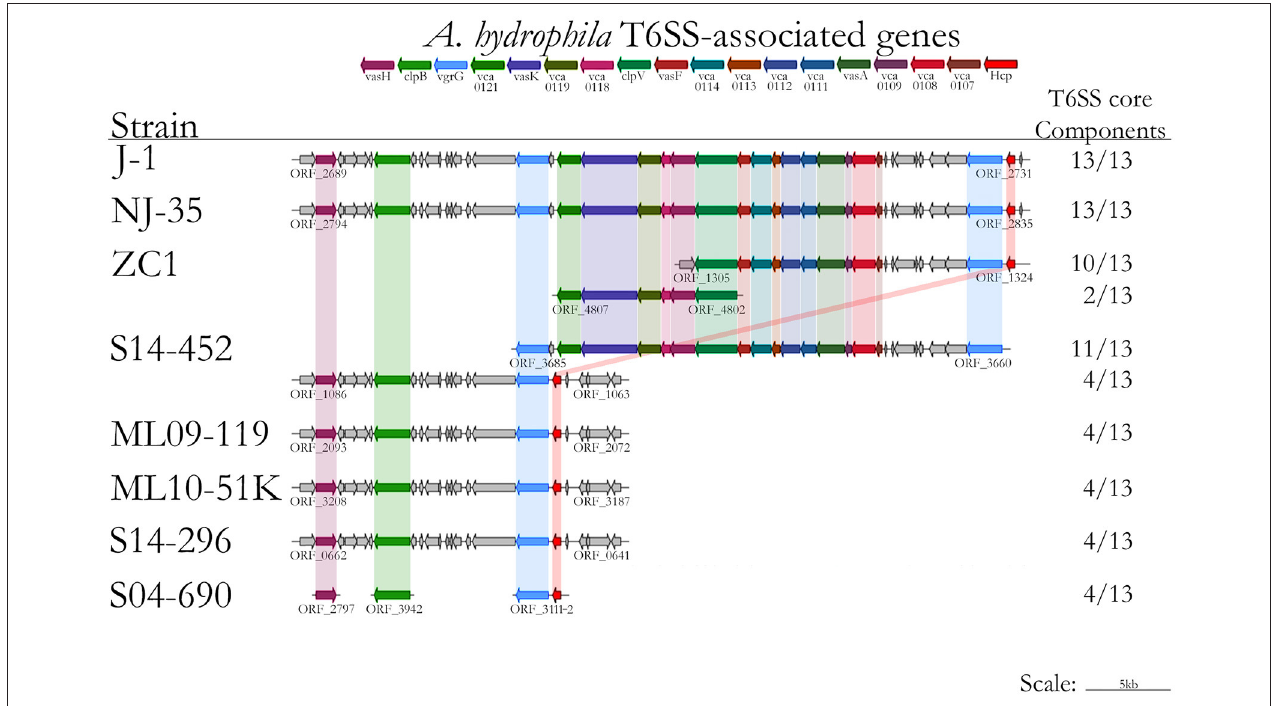
FIGURE 2 | Type VI secretion system gene prediction using the T346 Secretion System Hunter, with results including strains included in the immersion catfish challenge (ML09-119, MNL10-51K, S04-690, S14-296, S14-452, and ZC1) and representatives from Chinese strains (J-1, NJ-35, and